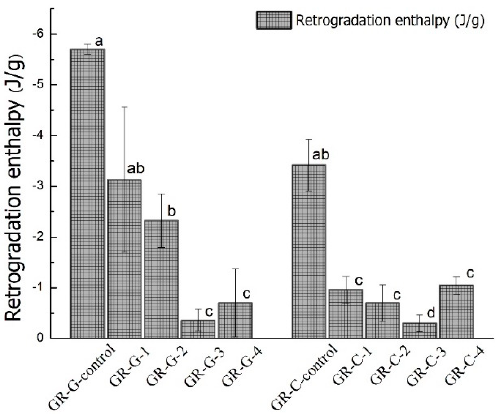
Figure 4. The retrogradation enthalpy after 14 days of storage at 4 °C of control glutinous rice gel sample (GR-G-control) and control sweetened glutinous rice cake (GR-C-control) and rice samples with 100 (GR-G-1, GR-C-1), 200 (GR-G-2, GR-C-2), 300 (GR-G-3, GR-C-3) and 400 (GR-G-4, GR-C-4) pulses of PEF treatment at 3 kV/cm. Mean values ± standard deviation of triplicates. Different letters on the bar graph indicated significant differences among the enthalpy of the samples ( p < 0.05) .